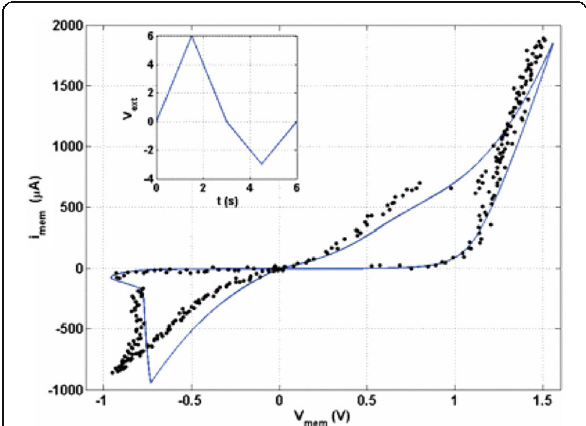
Fig. 7 Experimental data (black dots) and corresponding simulated I - V curve for the memristor (solid line) where i mem is the current through the memristor and v mem is the voltage across the entire memristor. The inset shows the externally applied voltage sweep is shown and the initial condition for w is set at 1.2 nm